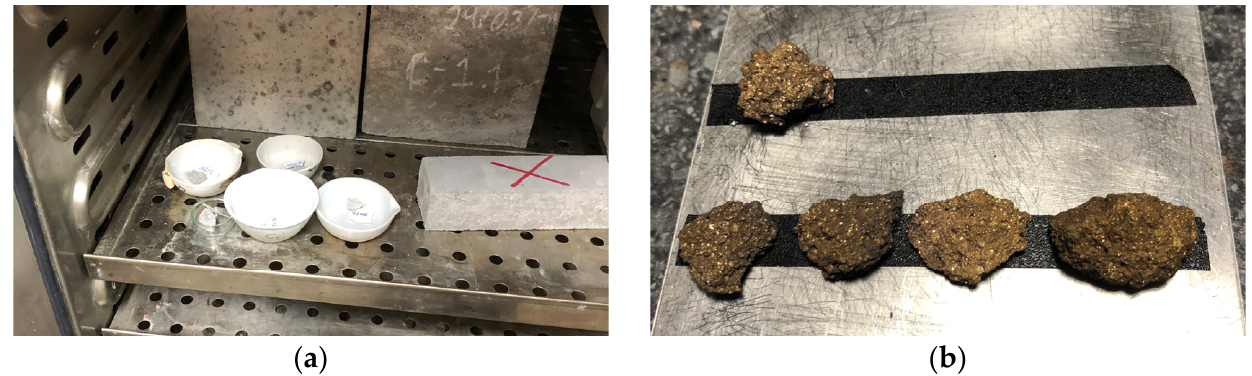
Figure 5. Sample preparation for SEM analysis: oven drying at 70 ◦ C ( a ); samples after metallisation ( b ). The samples analysed in the SEM were reduced to a size suitable for obtaining micro- graphic images. In order to assess the compactness of the material, the growth of cement hydration products and the possible cracks generated in the mechanical tests were